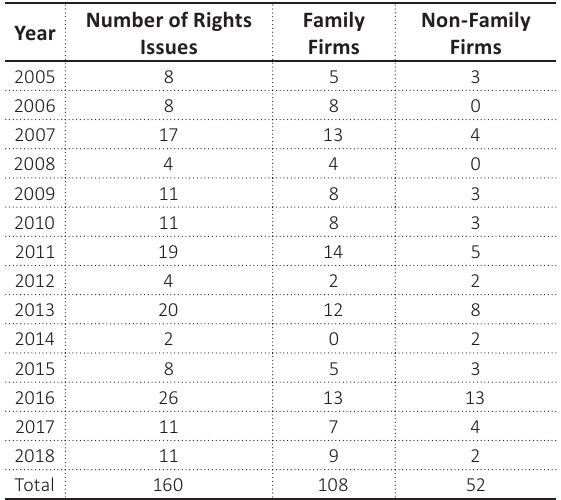
Table 1. Number of rights issues in